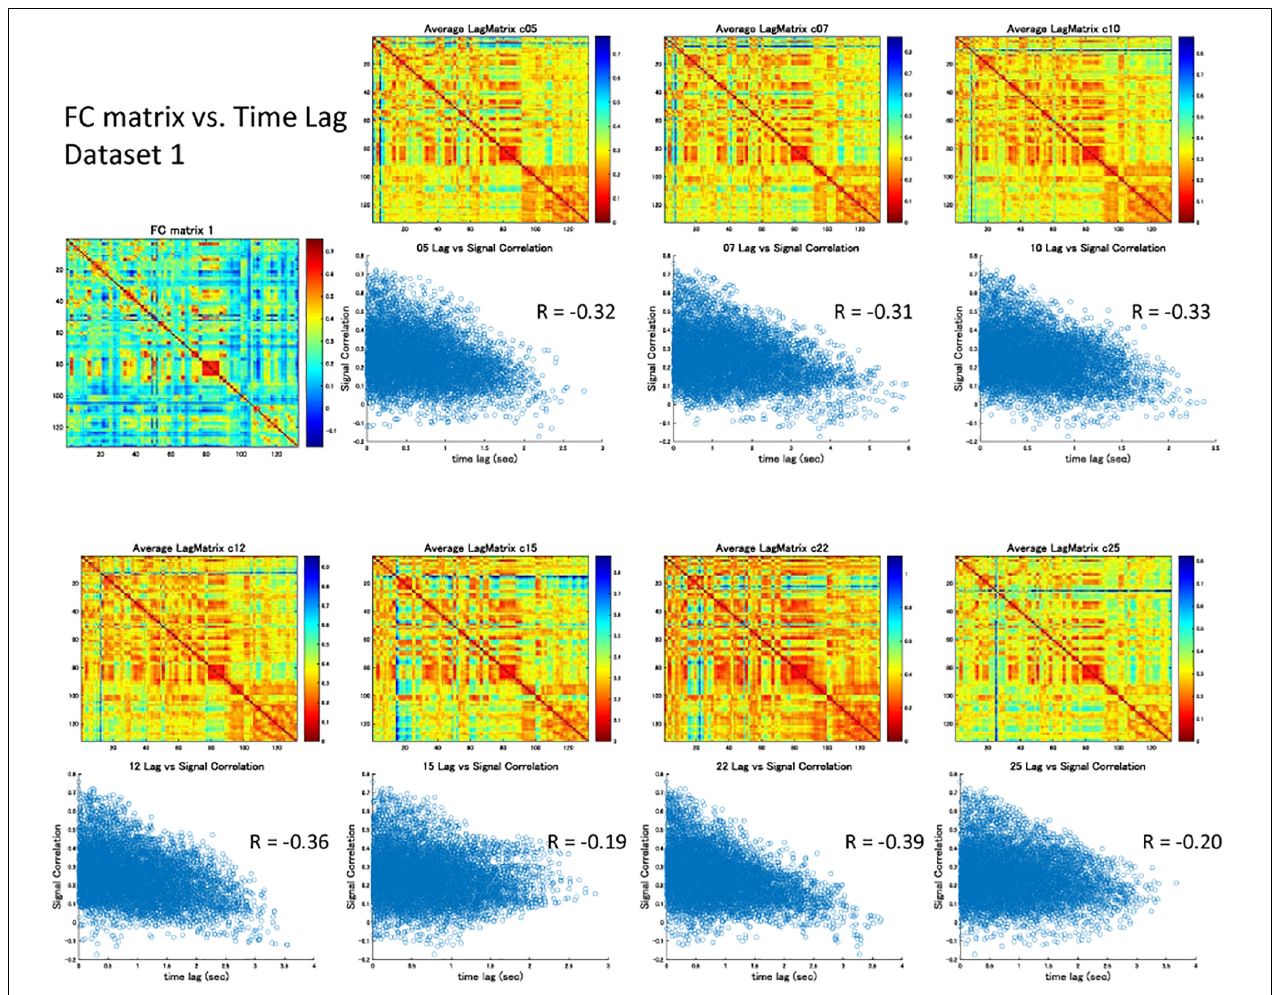
FIGURE 4 | Signal correlation matrix vs. Time lag matrix. For each global component, there was significant negative correlation between the strength of synchronization (FC) and the relative time lag between each ROI, which confirmed the contribution of the time lag of the global component to RSN